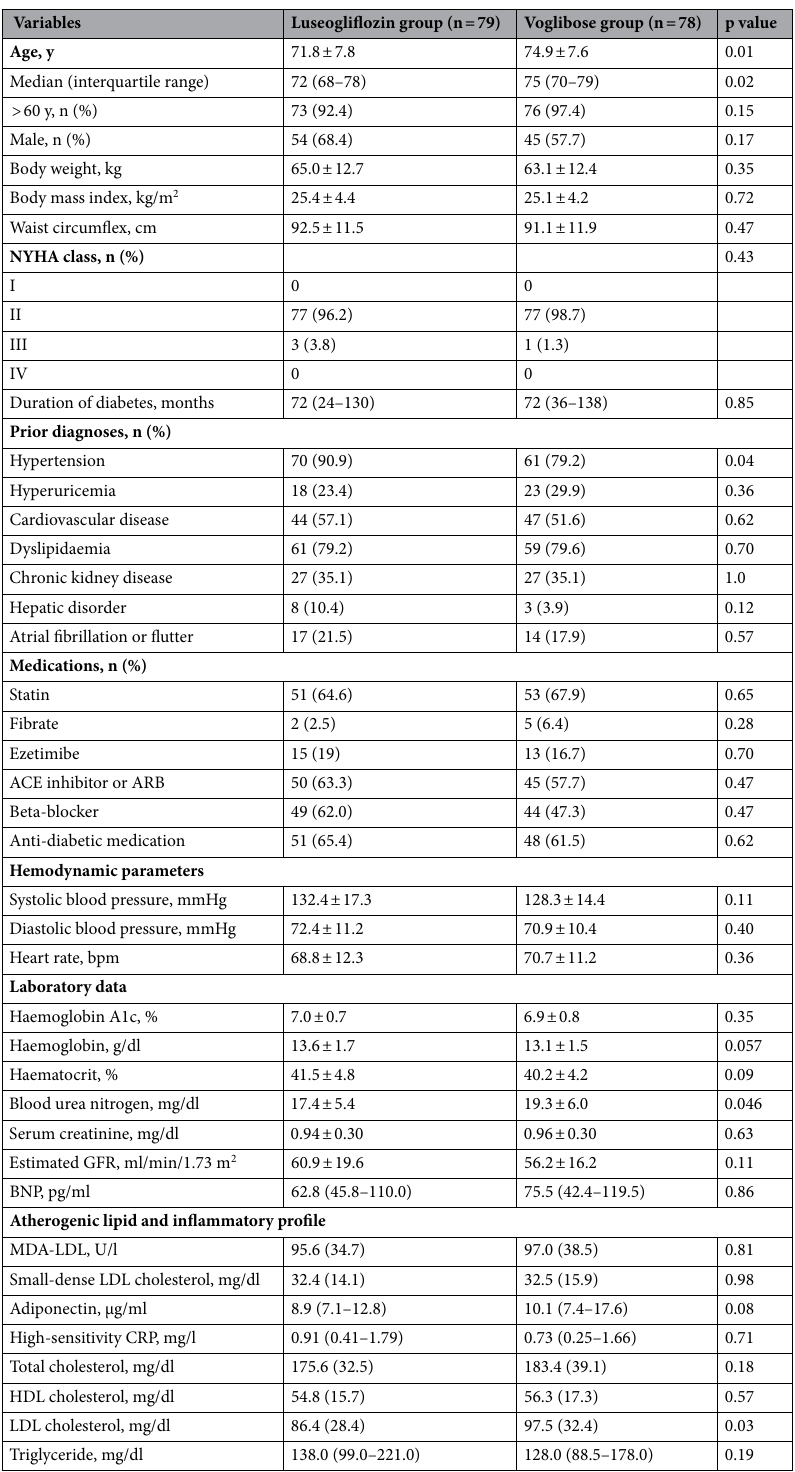
Table 1. Baseline patient characteristics. Data are presented as the mean ± standard deviation, n (%), or median (interquartile range). ACE angiotensin-converting enzyme, ARB angiotensin-receptor blocker, BNP b-type natriuretic peptide, CRP C-reactive protein, GFR glomerular filtration rate, HDL high-density lipoprotein, MDA-LDL malondialdehyde low-density lipoprotein, MRA mineralocorticoid receptor antagonist, NYHA New York Heart